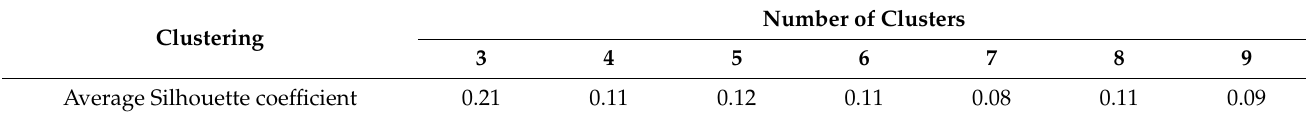
Table 3. Silhouette coefficient for determining the number of clusters.